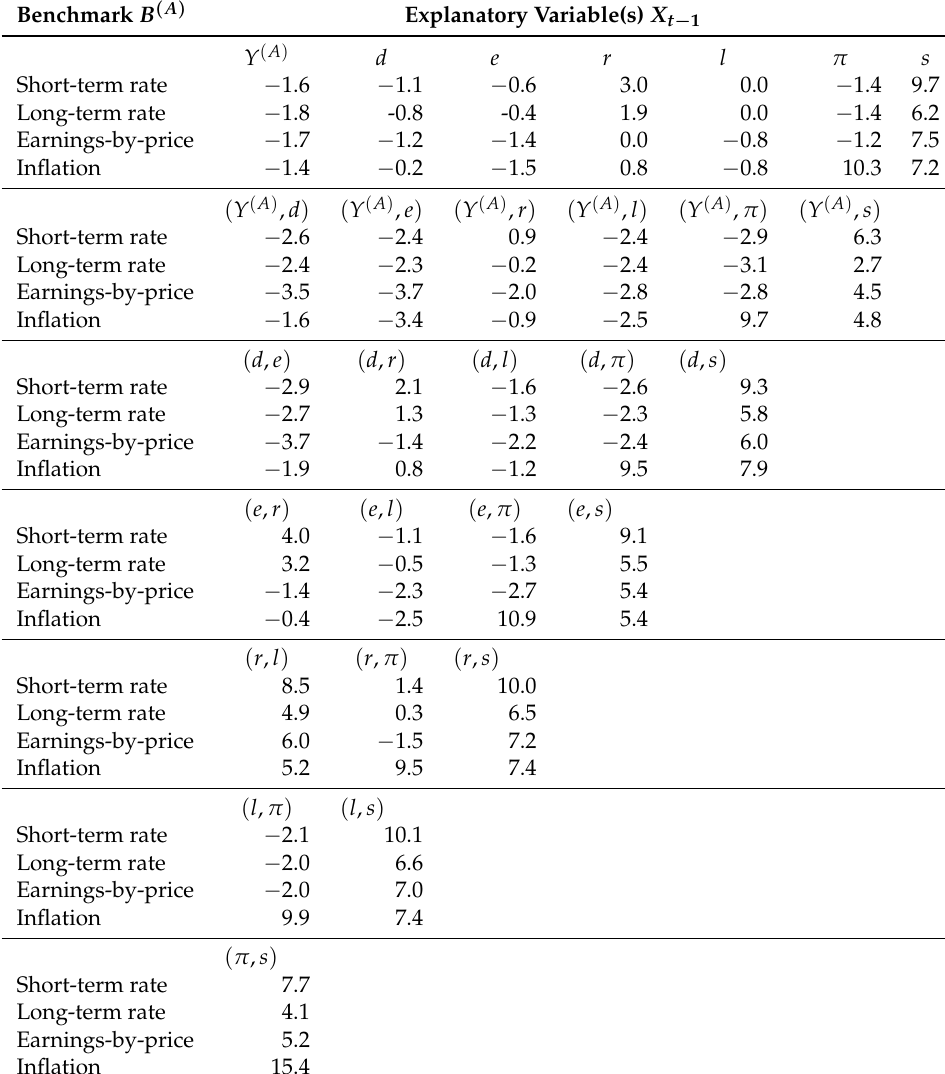
Table 2. Predictive power measured by R 2 benchmarking